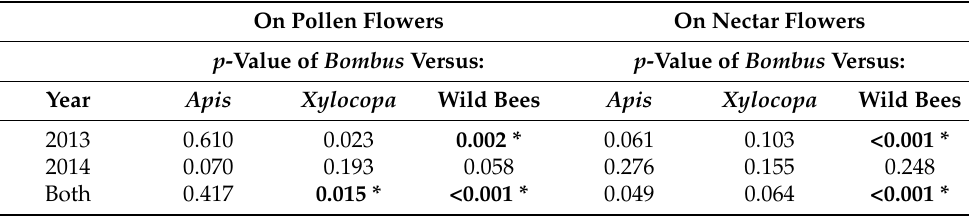
Table 5. Presence of bumblebees vs. each of the other three categories during the first hour after sunrise. On Pollen Flowers On Nectar Flowers During First Hour after Sunrise During First Hour after Sunrise p -Value of Bombus Versus: p -Value of Bombus Versus: